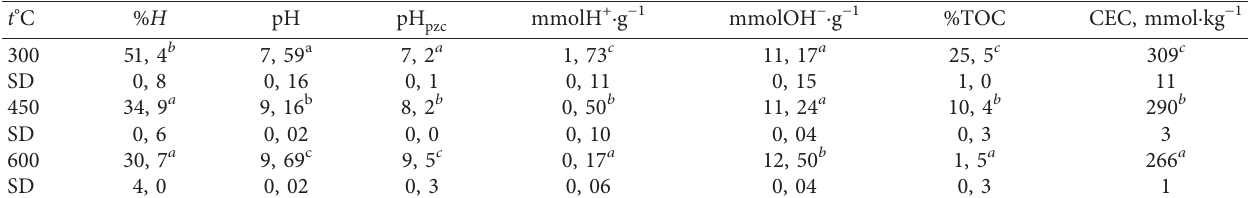
Table 1: Productivity efficiency and surface physical chemistry properties of